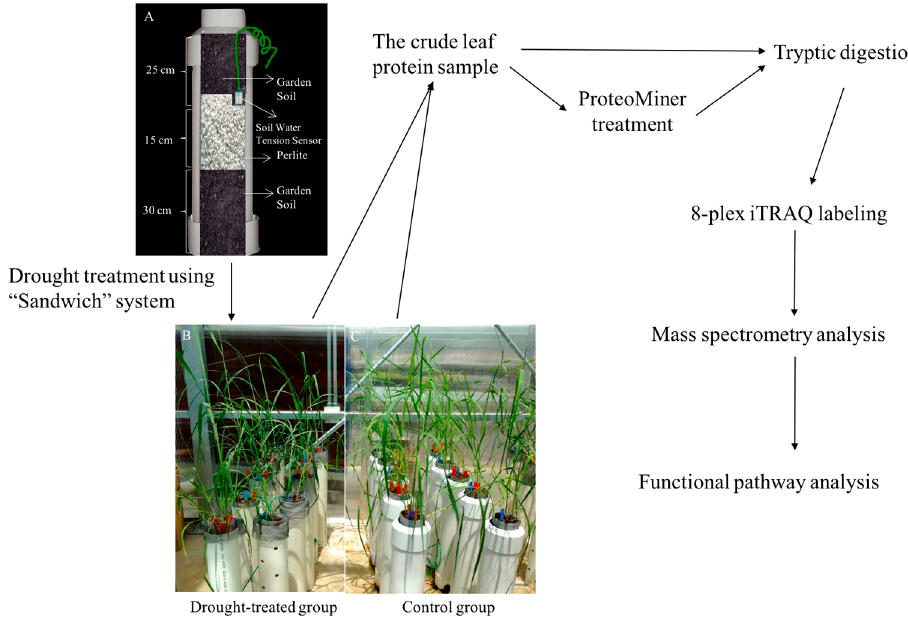
Figure 1. Flow chart of the drought treatments and quantitative proteomics procedure. Plants were grown in a “sandwich” system ( A ); During the 20th day of the water withholding period, physiological data were recorded on both drought-treated ( B ); and well-watered control plants ( C ). Leaf protein samples were extracted followed by the ProteoMiner enrichment. Quantitative proteomics analysis was performed using the crude leaf protein extracts and the ProteoMiner-enriched samples. Functional pathways were developed using information on the drought-induced changes in the leaf proteomes, and the association between protein expression and physiological properties was developed focusing on drought stress tolerance.